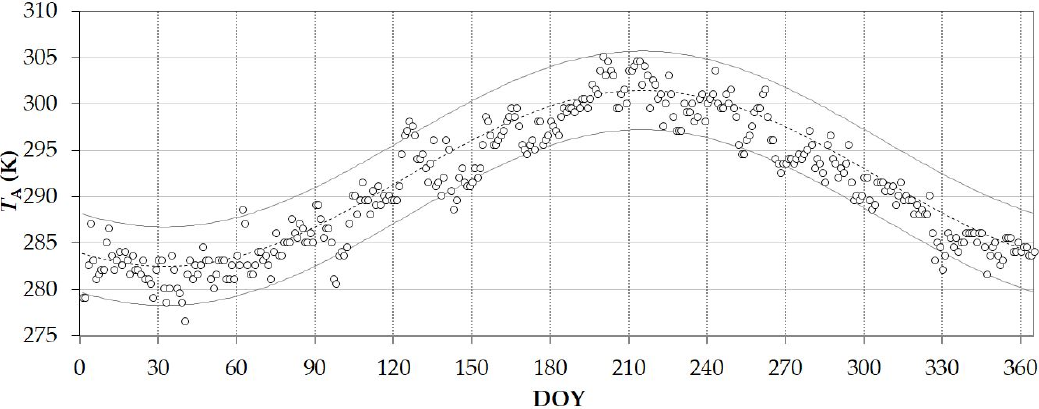
Figure 5. The temporal behaviour of the water surface temperature, T W (K), retrieved by Landsat 8 data, using both 189-034 and 190-034 scenes. A sinusoidal interpolation curve (continuous dashed line) and a confidence band of ± 2 × σ XY between measured and interpolated values (dark grey lines) are reported to facilitate the interpretation of the phenomenon.